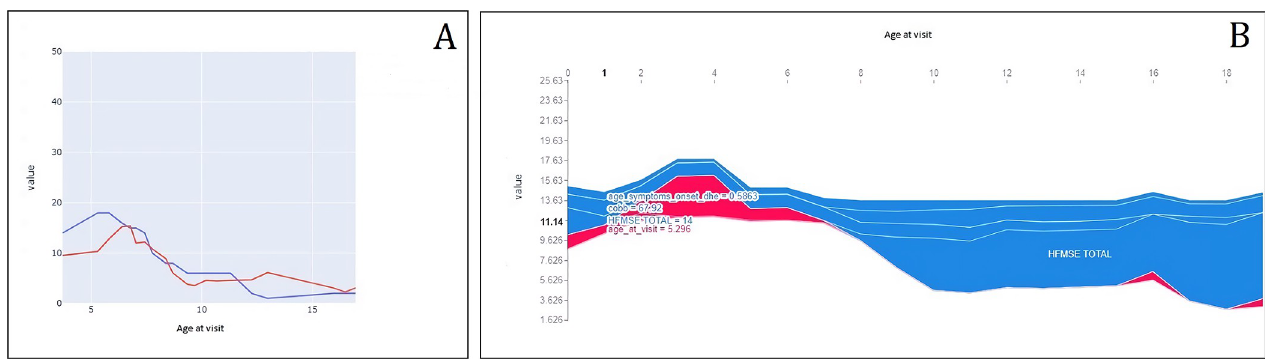
Fig 5. Prediction (A) and corresponding prediction by-prediction (B) for a sample testing patient. Key to Fig = Panel A: comparison between the actual 12 months trajectory (blue) of a testing set patient and the corresponding trajectory predicted by the 12-months model (red). Panel B: a focus on the predicted trajectory to show the variables contributing to the predictions along the trajectory, according to the SHAP framework. The red area represents positive contribution to the prediction, while the blue area represent negative contribution (e.g.: the first prediction (HFMSE equal to 11.14) relies on the positive contribution of age at current visit (5.3 years), and the negative contributions of age at symptoms onset (0.58 years), Cobb angle value (67.9), and previous HFMSE value).